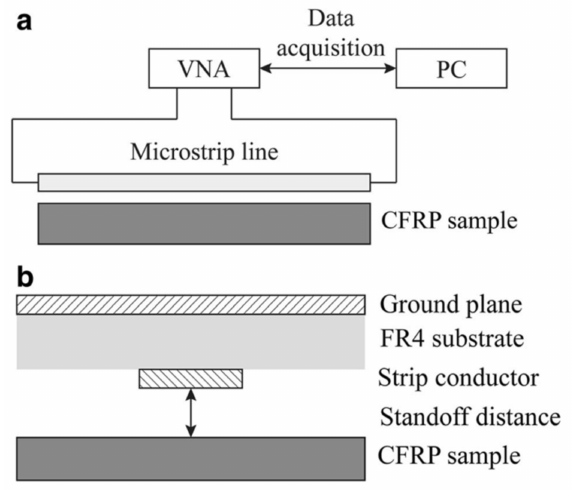
Figure 10. Detection system with microstrip line sensor ( a ) experiment setup ( b ) cross-section [56].